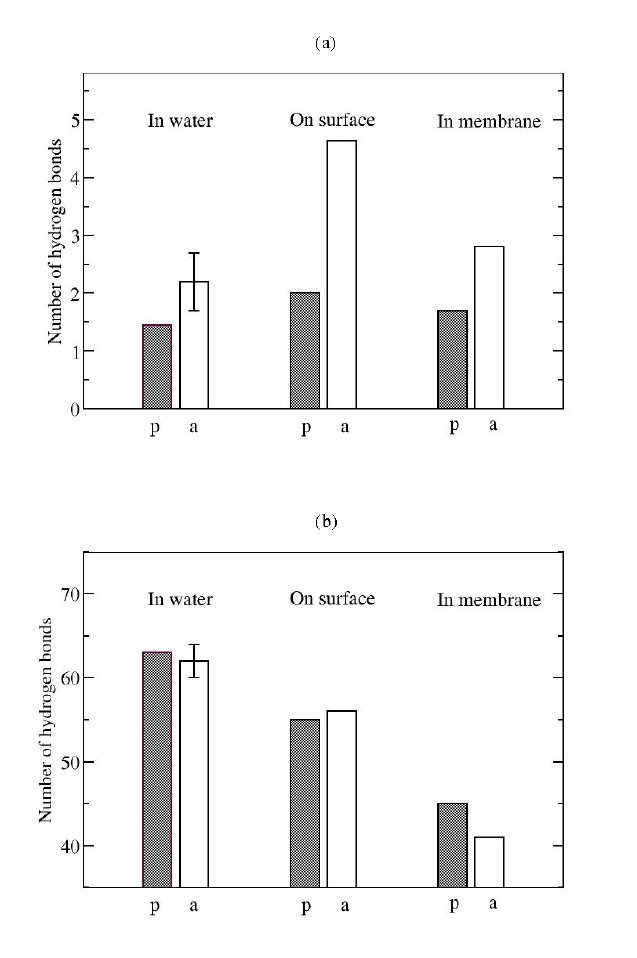
Figure 7. Average number of endogenic (a) and exogenic (b) hydrogen bonds between two PG1 peptides in all three studied environments. p: the parallel; a: the antiparallel β -sheet arrangement of the PG1